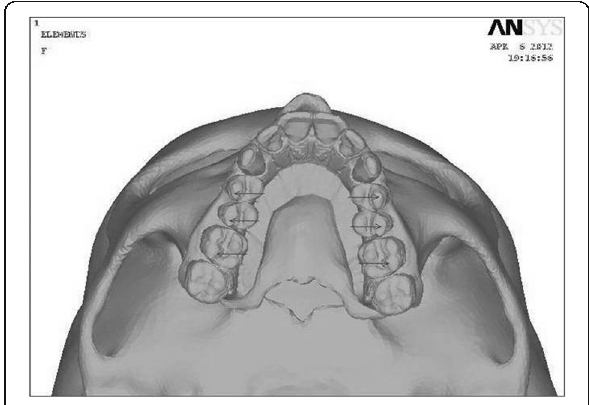
Fig. 6 Force of 19 kg/mm 2 was applied over the crown of premolars and first molar